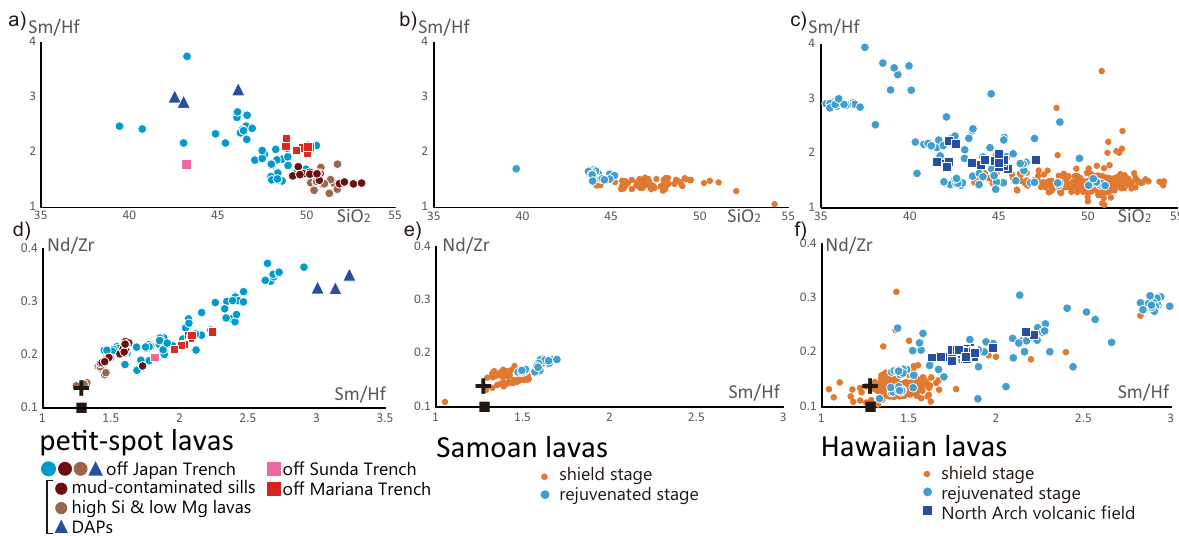
Fig. 4 Geochemical compositions of petit-spot lavas and Samoan and Hawaiian lavas. Hawaiian lava compositions ( c , f ) are from the GeoRoc database (http://georoc.mpch-mainz.gwdg.de/) 74 . The representative N-MORB and OIB compositions are shown by the black square and cross, respectively 75 . Samoan lava compositions ( b , e ) are after ref. 16 . The data of petit-spot basalts ( a , d ) are available in Supplementary Data 1 1,12,14,31,32 . “ Mud- contaminated sills ” and “ high Si & low Mg lavas ” are described by “ D02 ” 1 and “ G1c ” 31 ,